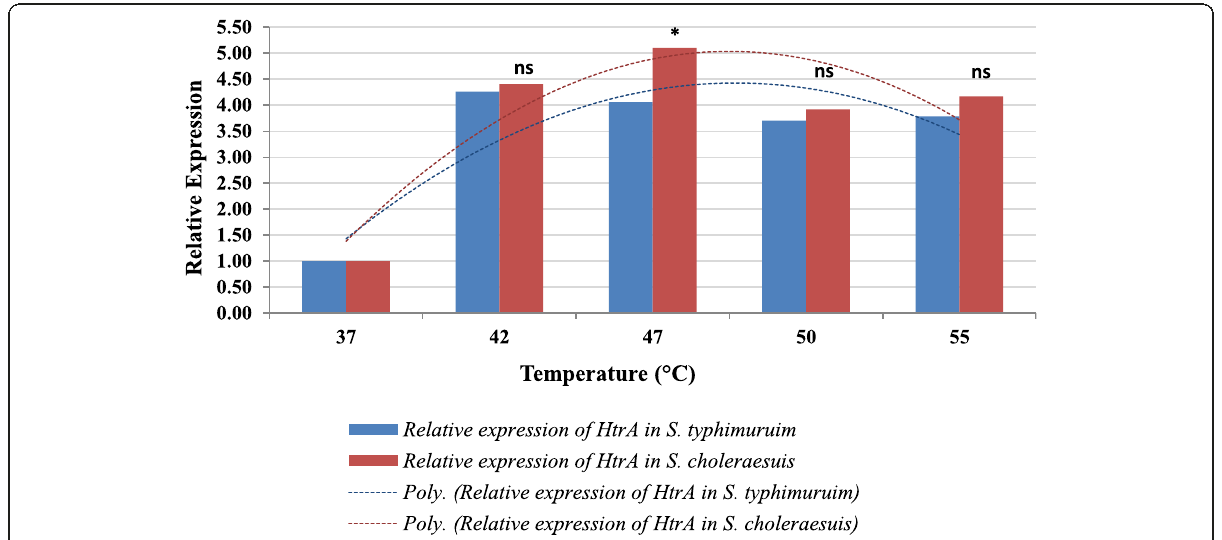
Fig. 4 Relative expression of HtrA gene in S. typhimurium and S. choleraesuis grown under different temperatures. *Significant difference between both bacteria at temperature. ns, no significant difference; Poly., polynomial